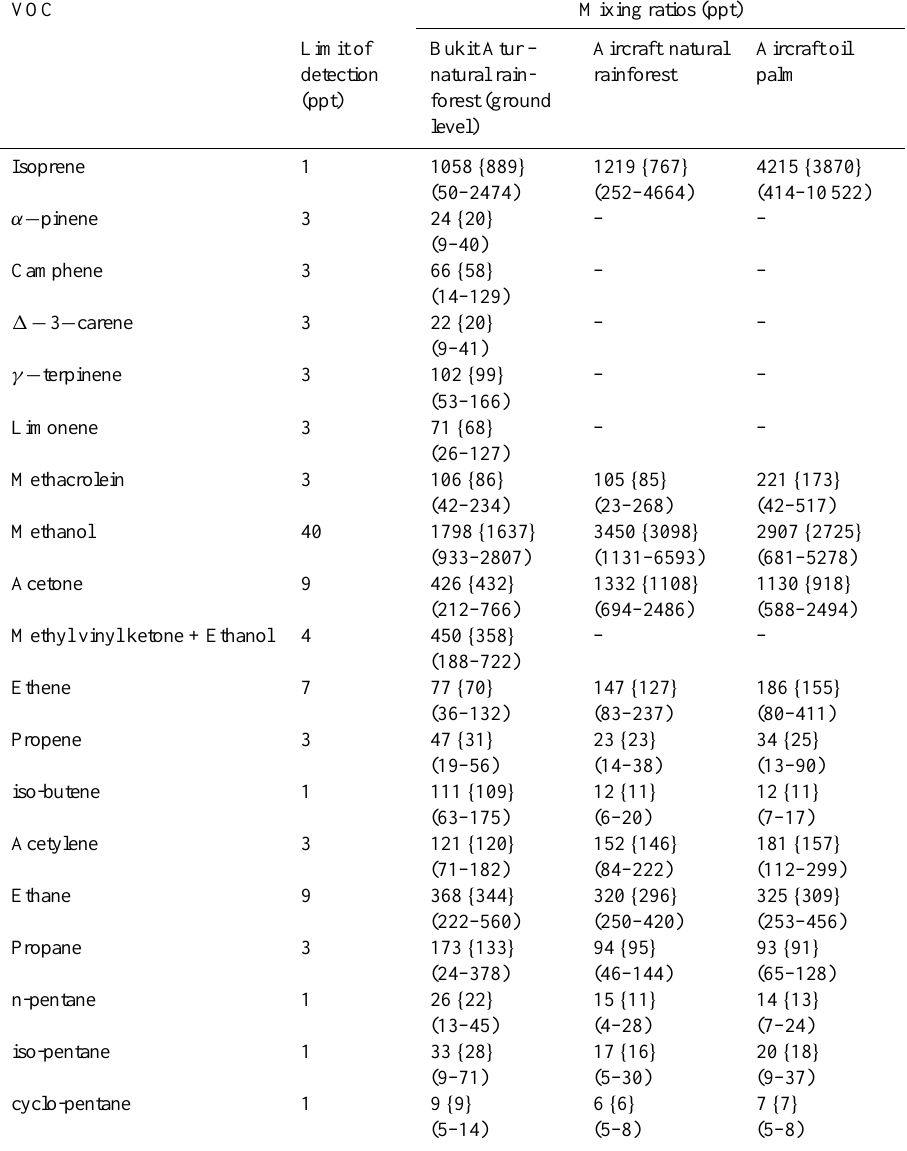
Table 1. Mean average daytime VOC mixing ratios observed within the natural rainforest at Bukit Atur, and in air samples collected above the natural rainforest and oil palm plantations. In each case the range of observed daytime mixing ratios inppt are given in brackets (5th and 95th percentiles) and the median mixing ratio is shown in curly brackets. Note that some VOCs routinely measured by the ground-based instrument, including acetaldehyde and benzene, are not reported as a result of instrumentation difficulties experienced during the OP3 field